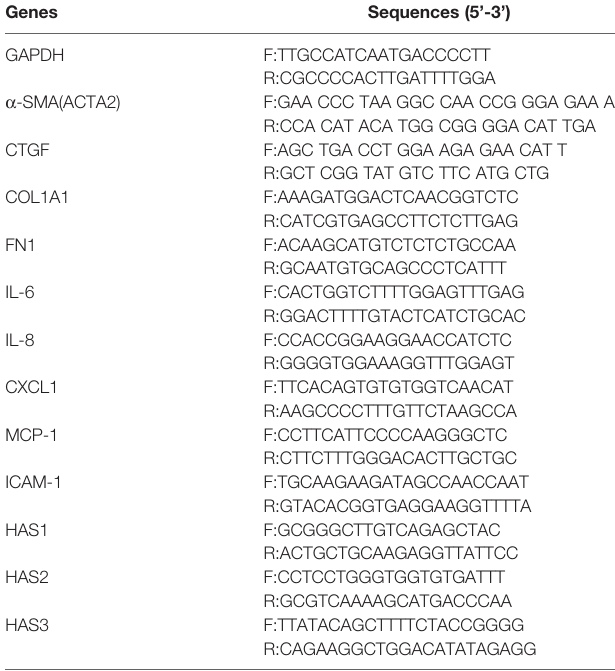
TABLE 2 | Primer sequences of qRT-PCR.